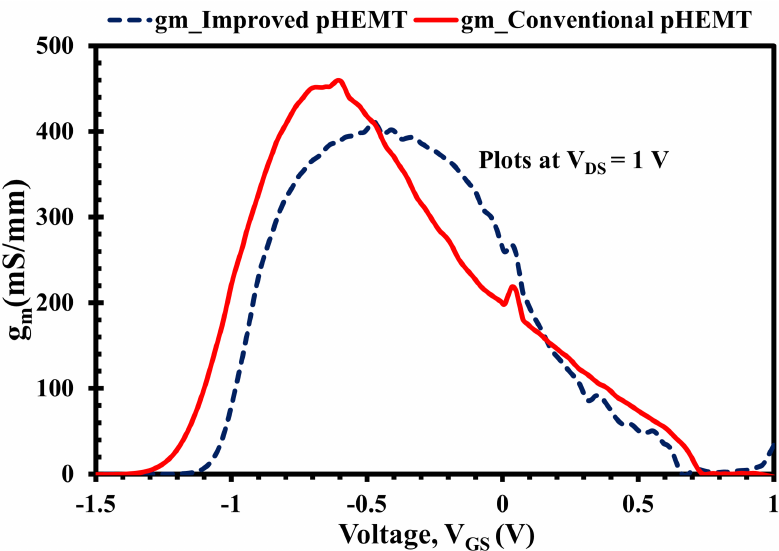
Figure 9. XMBE171 (conventional pHEMT) and XMBE56 (improved pHEMT) extrinsic transconduc- tance (g m ) at V DS = 1 V with 2 × 100 µ m gate